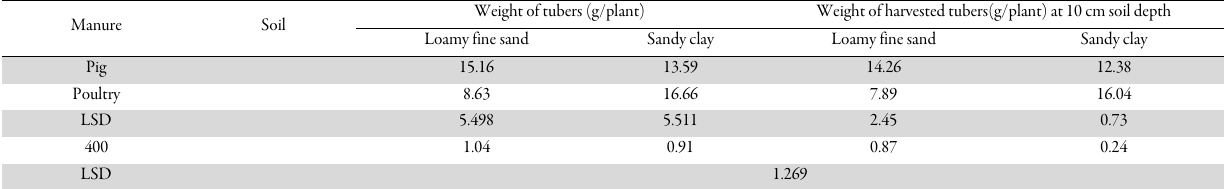
Table 10. Interaction between soil texture and manure types on tuber weight of tiger nut per plant and weight of tubers harvested at 10 cm depth of soil. Values are a mean of 5 plants Manure